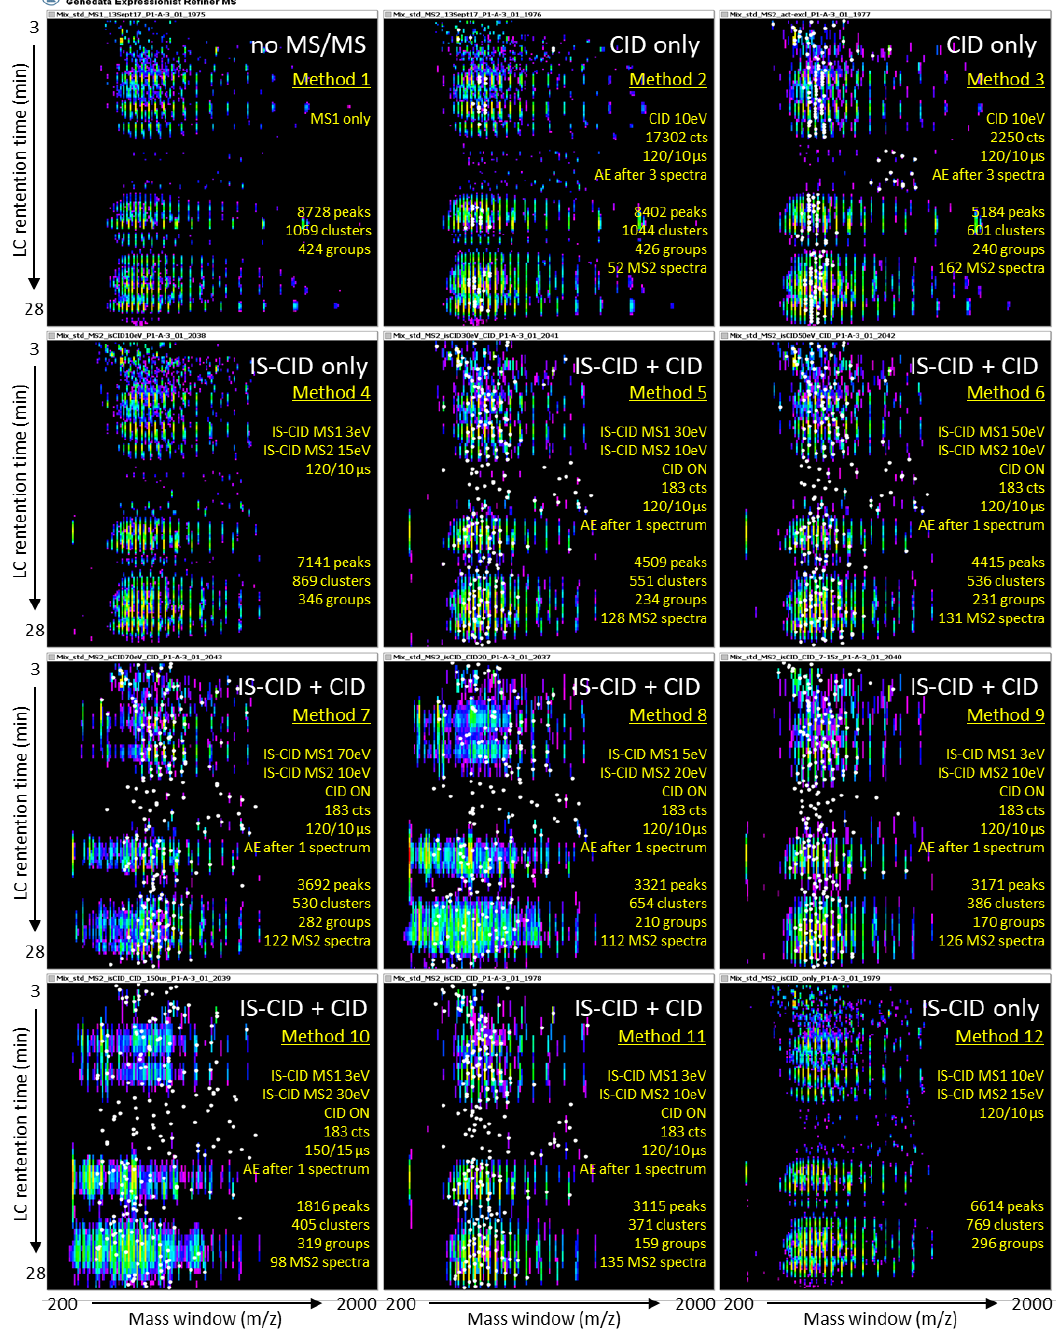
Figure 3. LC-MS maps of the mixed protein standards sample visualised in Genedata Refiner with the scanned mass range (200–2000 m / z ) on the x axis and LC retention time (3–28 min) on the y axis across all 12 methods following data processing. White dots represent true MS/MS (MS2) events using conventional CID fragmentation. AE, active